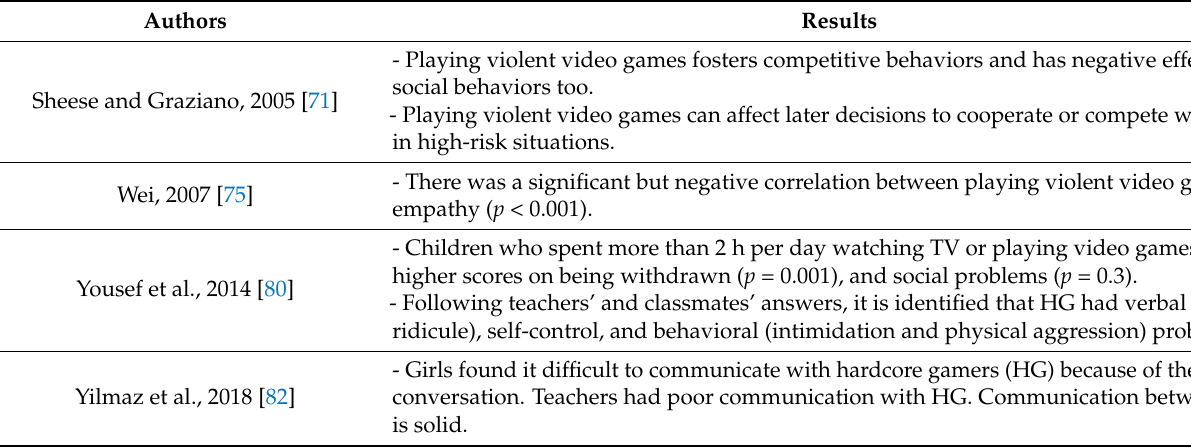
Table 5. Results related to social